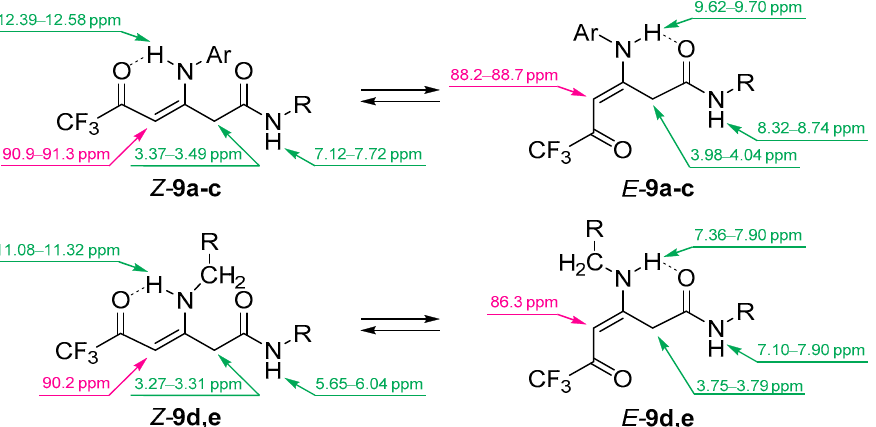
Figure 3. Equilibrium between Z - and E -isomers of enamides 9 and their characteristic chemical shifts in 1 H (in green) and 13 C (in magenta) NMR in CDCl 3 .